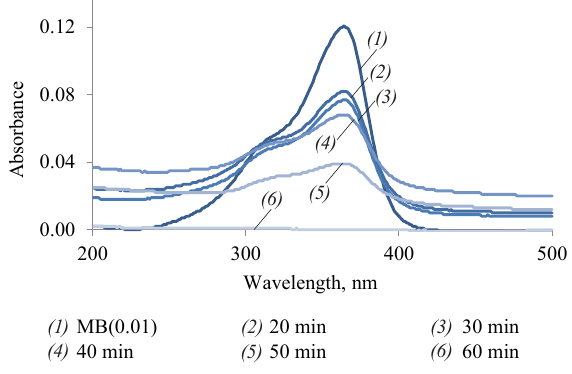
Fig 1: Absorbance of methylene blue at different contact time Fig ure 1 Absorbance of methylene blue at different contact